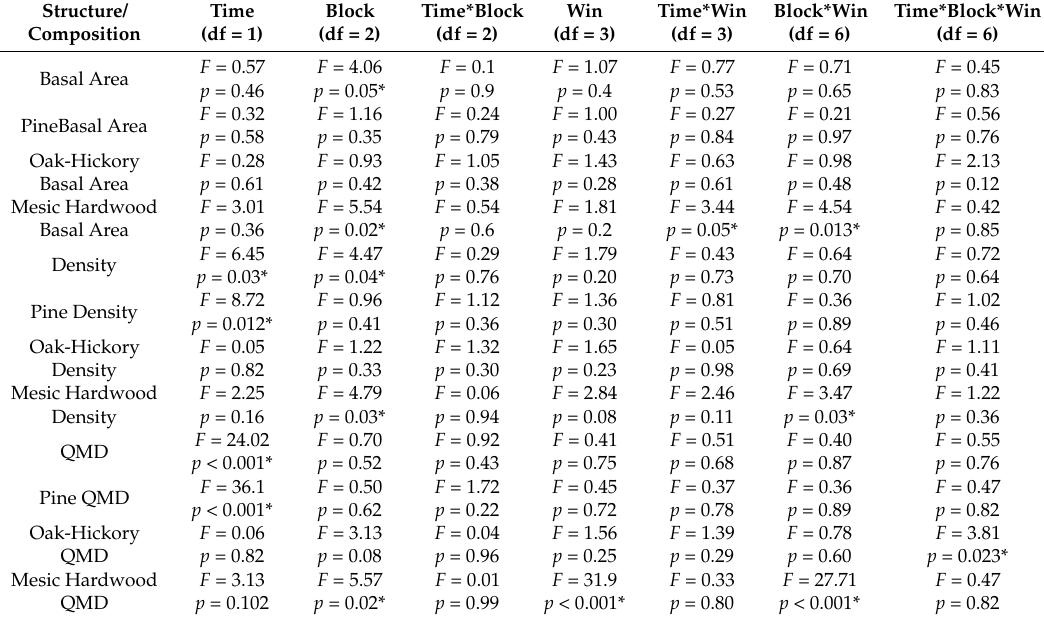
Table 3. Analysis of Variance table for effects of repeated growing season burn effects on overstory structure and composition over time, block, and timing of burn window (Win) in mixed pine–hardwood forests of the Piedmont National Wildlife Refuge near Macon, Georgia, USA. Quadratic mean diameter is abbreviated by QMD. p -values ≤ 0.05 are noted with an *. Greenhouse–Geisser adjusted p -values (GG) are given for those repeated measures data that did not meet circularity